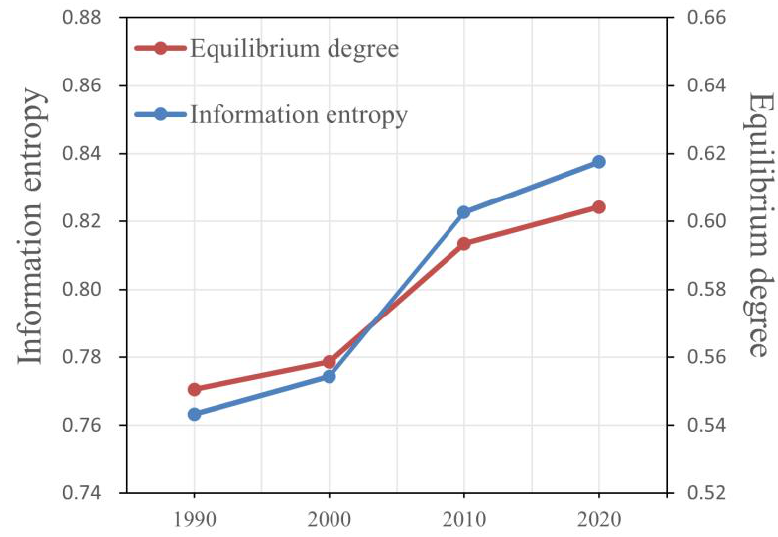
Figure 5. Change of land use information entropy and equilibrium degree.